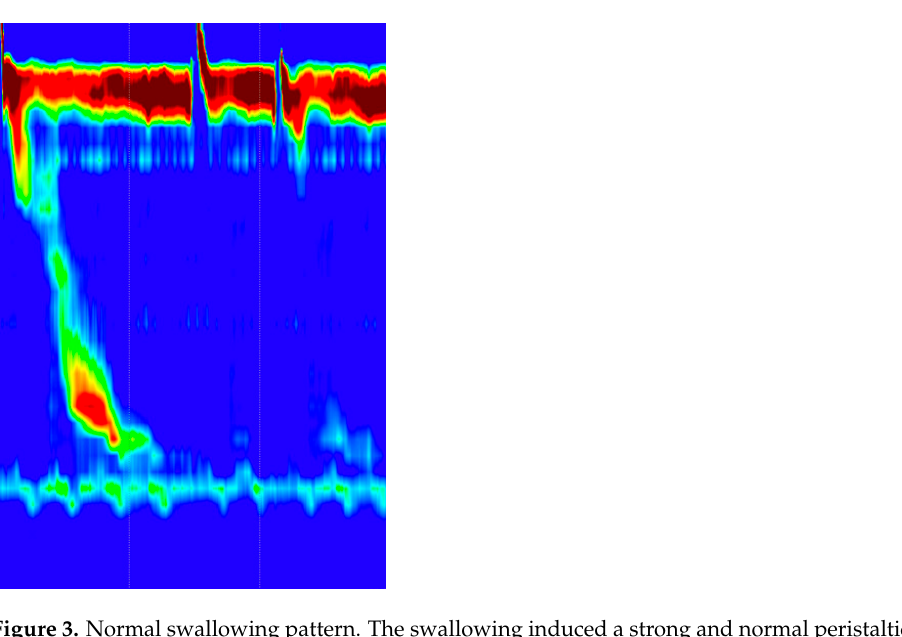
Figure 3. Normal swallowing pattern. The swallowing induced a strong and normal peristaltic wave.